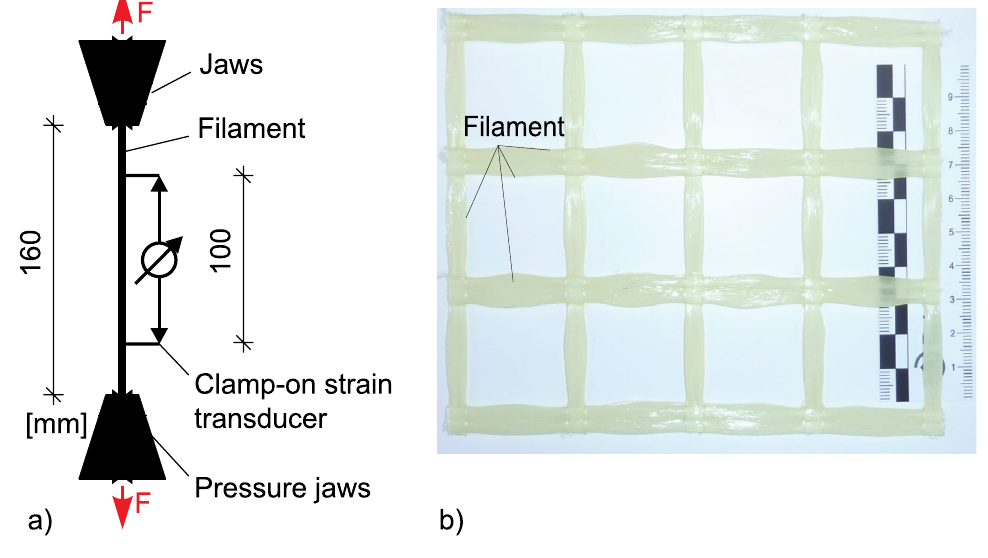
Figure 1. ( a ) Standardised tensile test set-up 17 . ( b ) Picture of the testing grid of AR-Glass reinforcement 15